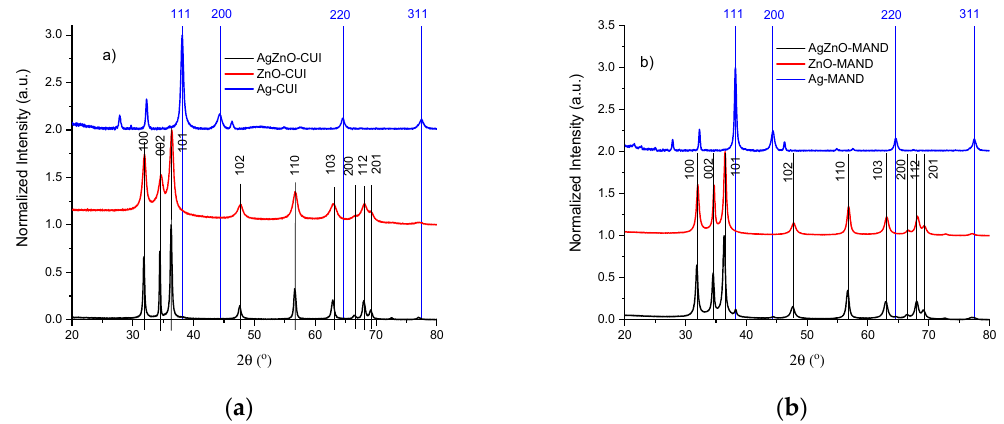
Figure 1. XRD patterns of the samples obtained in ( a ) cloves extract and ( b ) mandarins extract.